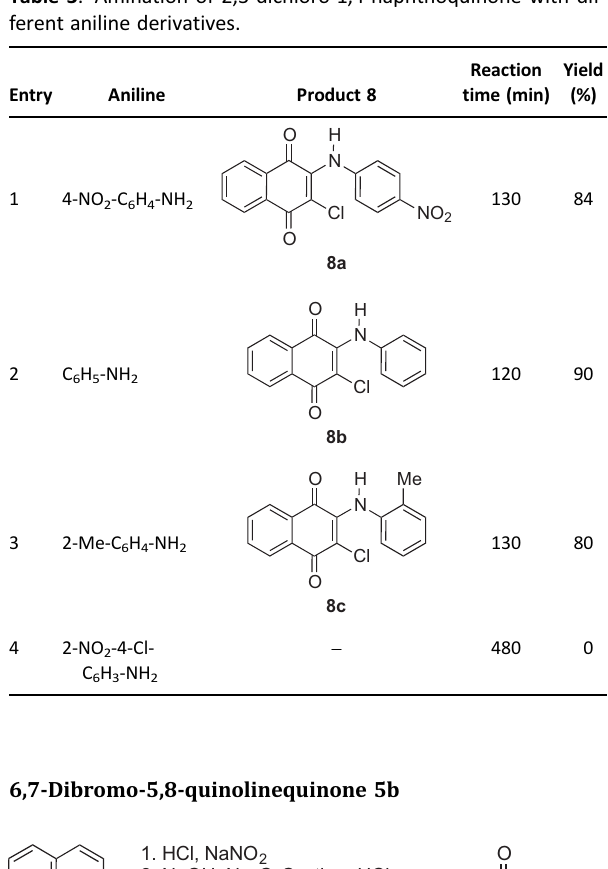
filtered and recrystallized twice from butanol to yield 6,7- Table 3 . Amination of 2,3-dichloro-1,4-naphthoquinone with dif-